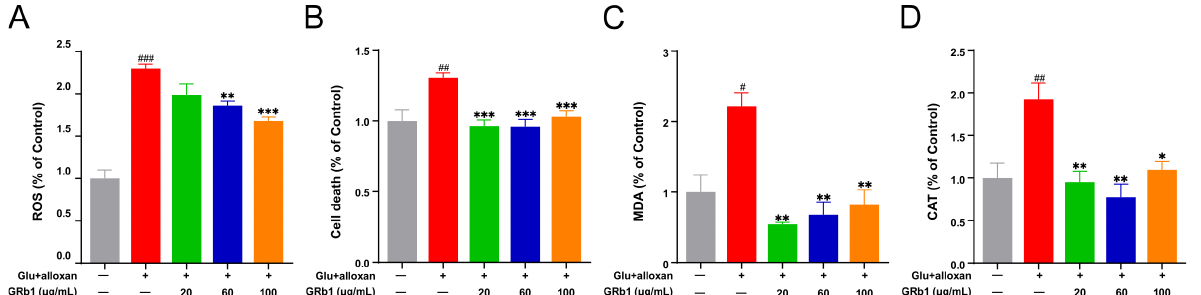
Figure 7. GRb1 treatment attenuates oxidative stress in a diabetes zebrafish model. ROS production ( A ), cell death ( B ), MDA levels ( C ) and CAT activity ( D ) in diabetes zebrafish larvae treated with different concentrations of GRb1. Results are expressed as mean ± SEM. ### p < 0.001, ## p < 0.01, # p < 0.05 vs. control. *** p < 0.001, ** p < 0.01, * p < 0.05 vs. model.